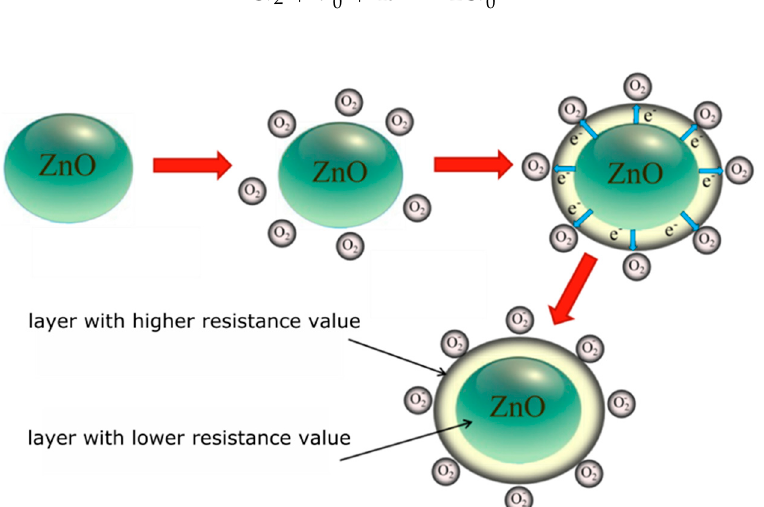
Figure 9. Diagram of the chemical sorption process of oxygen on the surface of an n-type oxide